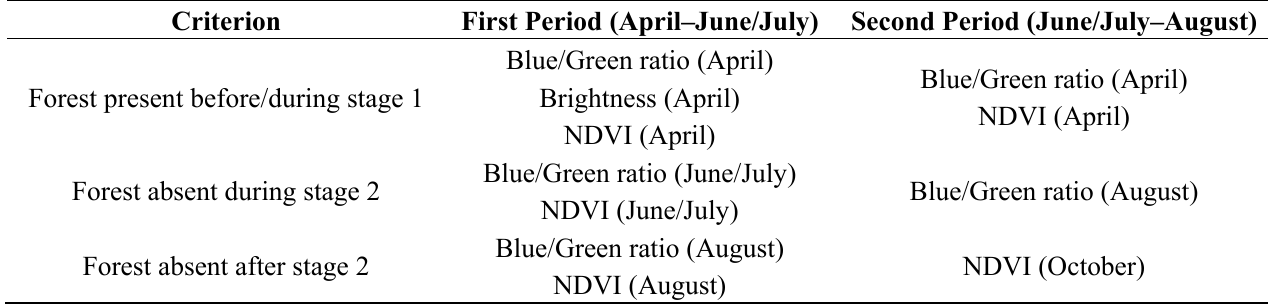
Table 2. The indices used to create the three criteria used to extract the forest loss areas (see Figure